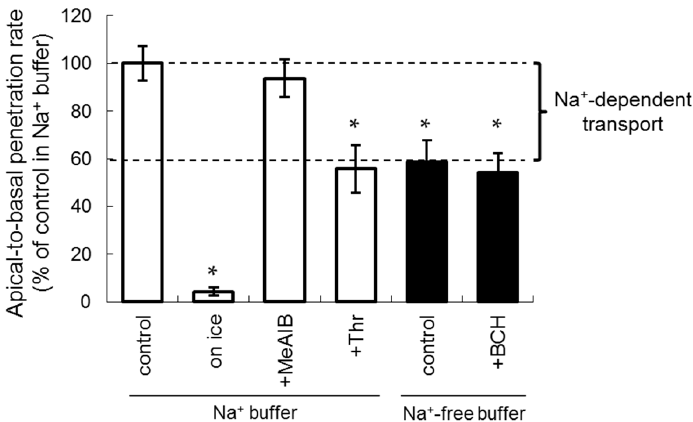
Figure 3. The inhibition profile of [ 14 C]fluciclovine (10 µ M) apical-to-basal transport using the LLC-PK1 monolayer model under the indicated conditions, i.e., temperature and 1 mM inhibitors in Na + buffer (white bar, n = 5–14) or Na + -free buffer (black bar, n = 9). Each data point represents the mean ± SD. * p < 0.05 vs control in Na + buffer.